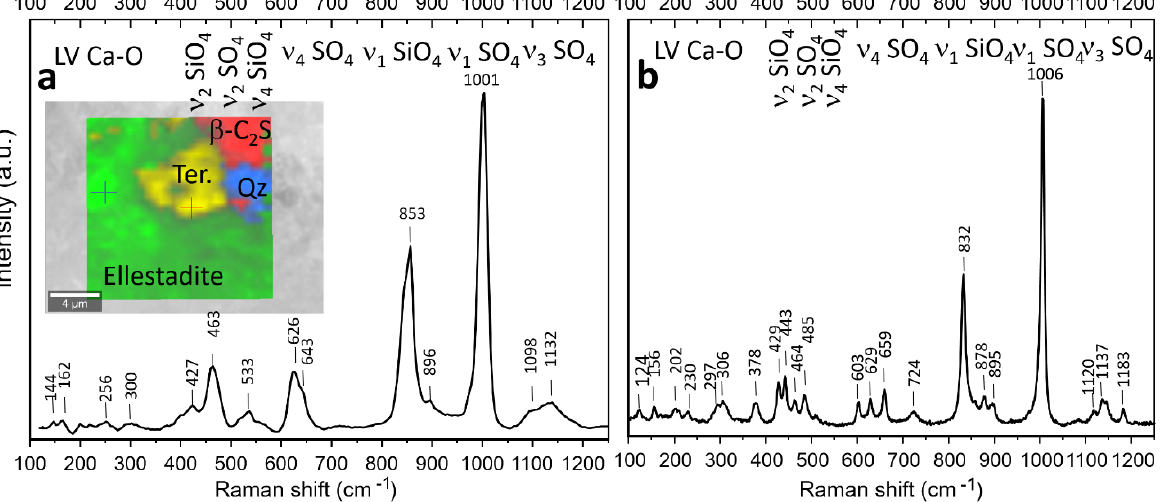
Figure 5. ( a ) Raman spectrum of chlorellestadite in sample D2 calcined at 1100 °C. The insert shows a Raman image of the distribution of chlorellestadite, ternesite, β -C 2 S, and quartz. ( b ) Raman spectrum of ternesite in the same sample. The crosses in the insert show the points where the corresponding single spectra were taken.